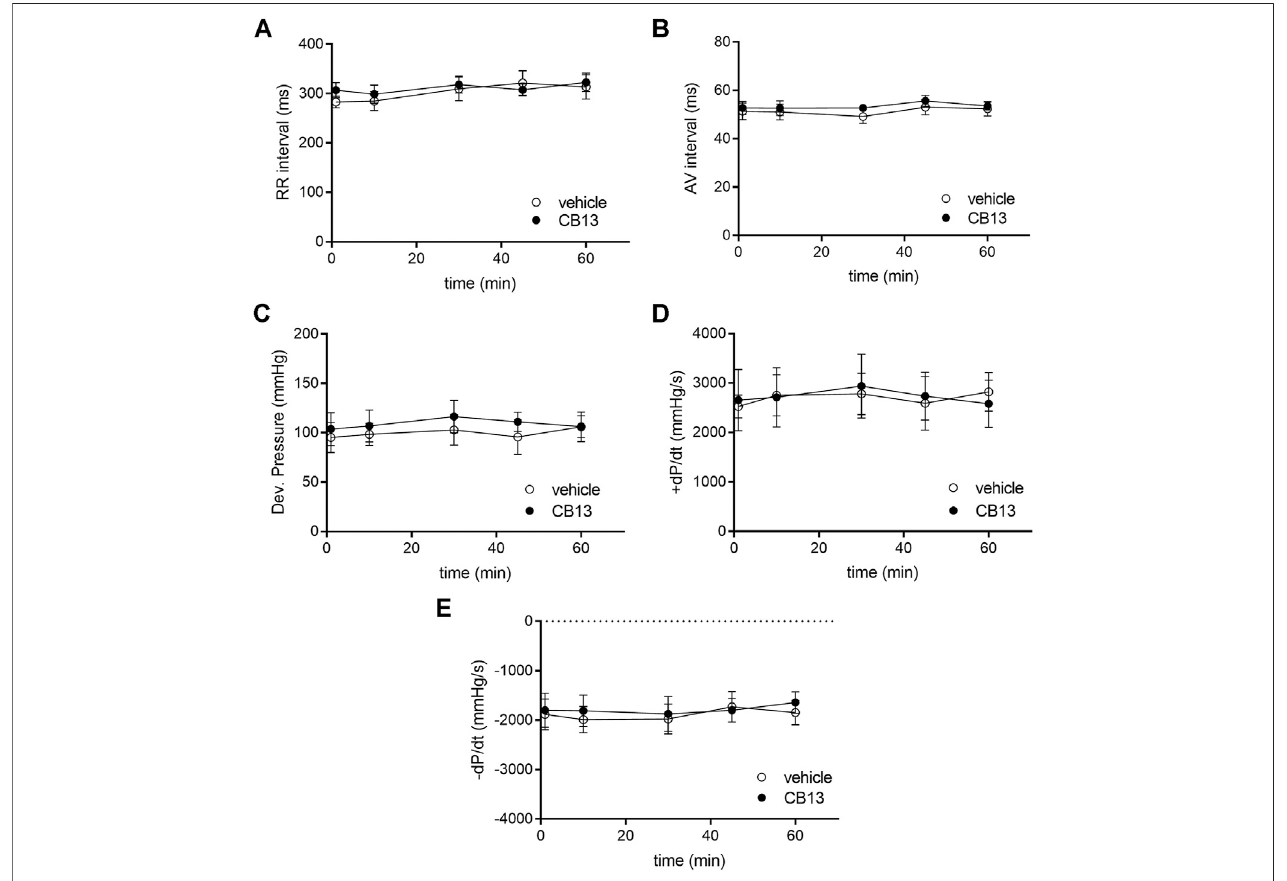
FIGURE 2 | Absence of chronotropic, dromotropic or hemodynamic effects of CB13 in the non-paced rat heart. Isolated rat heart preparations were exposed to either 1 μ M of CB13 or vehicle alone, and (A) RR interval, (B) atrioventricular (AV) interval, (C) developed pressure (D) maximal rate of rise of LVP (+dP/dt), and (E) maximal rate of decay of LVP ( − dP/dt) were assessed. All parameters demonstrated stability over time with no difference between the CB13 and vehicle preparations. ( n (cid:1) 5). Data presented as mean ± SEM.